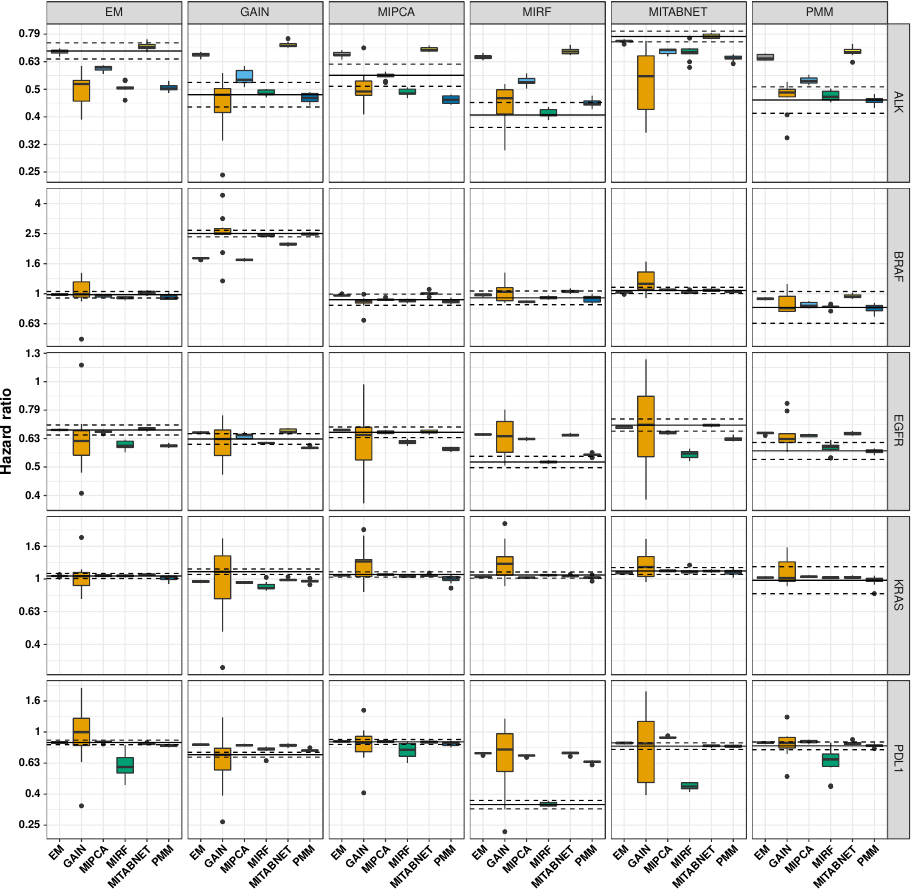
Figure A2. Estimates of hazard ratios for ALK, BRAF, EGFR, KRAS, and PDL1. The solid line indicated the hazard ratio estimated for the imputation algorithm, dashed line 95% confidence interval. Boxplot shows the point estimates of over 100 amputated and re-imputed samples for each imputation